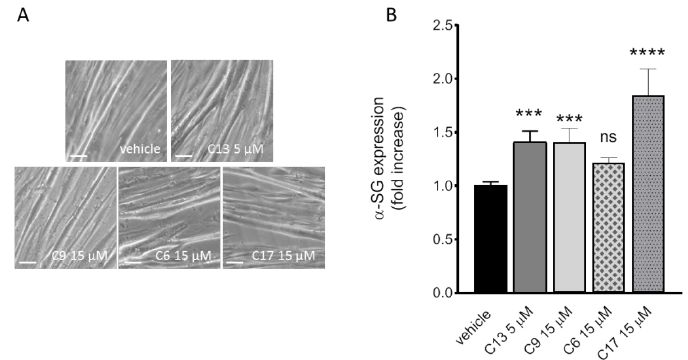
Figure 1. Rescue of α-SG by cystic fibrosis transmembrane regulator (CFTR) correctors in LGMD2D myotubes. Myogenic cells from a patient carrying the L31P/V247M α-SG mutations were differentiated for 7 days and treated for the last 72 h with either 1‰ DMSO (vehicle), C13, C9, C6 or C17 at the indicated concentrations. ( A ) phase contrast images of myotubes at the end of corrector incubation are indistinguishable from the control ones. Scale bar corresponds to 100 µm. ( B ) Densitometric analysis of western blot experiments performed with total protein lysates from LGMD2D myotubes treated as indicated. The α-SG protein was revealed by using specific primary antibody and normalized by the content of β-actin. α-SG content in di ff erent samples was expressed as the fold increase ( +/ − SD) of the amount present in the vehicle treated myotubes, and is the mean value of 3-4 independent experiments (each performed in duplicate). Statistical analysis was performed by One-way ANOVA test followed by multiple comparisons Dunnett’s test; n.s., p > 0.05; ***, p ≤ 0.001; ****, p ≤